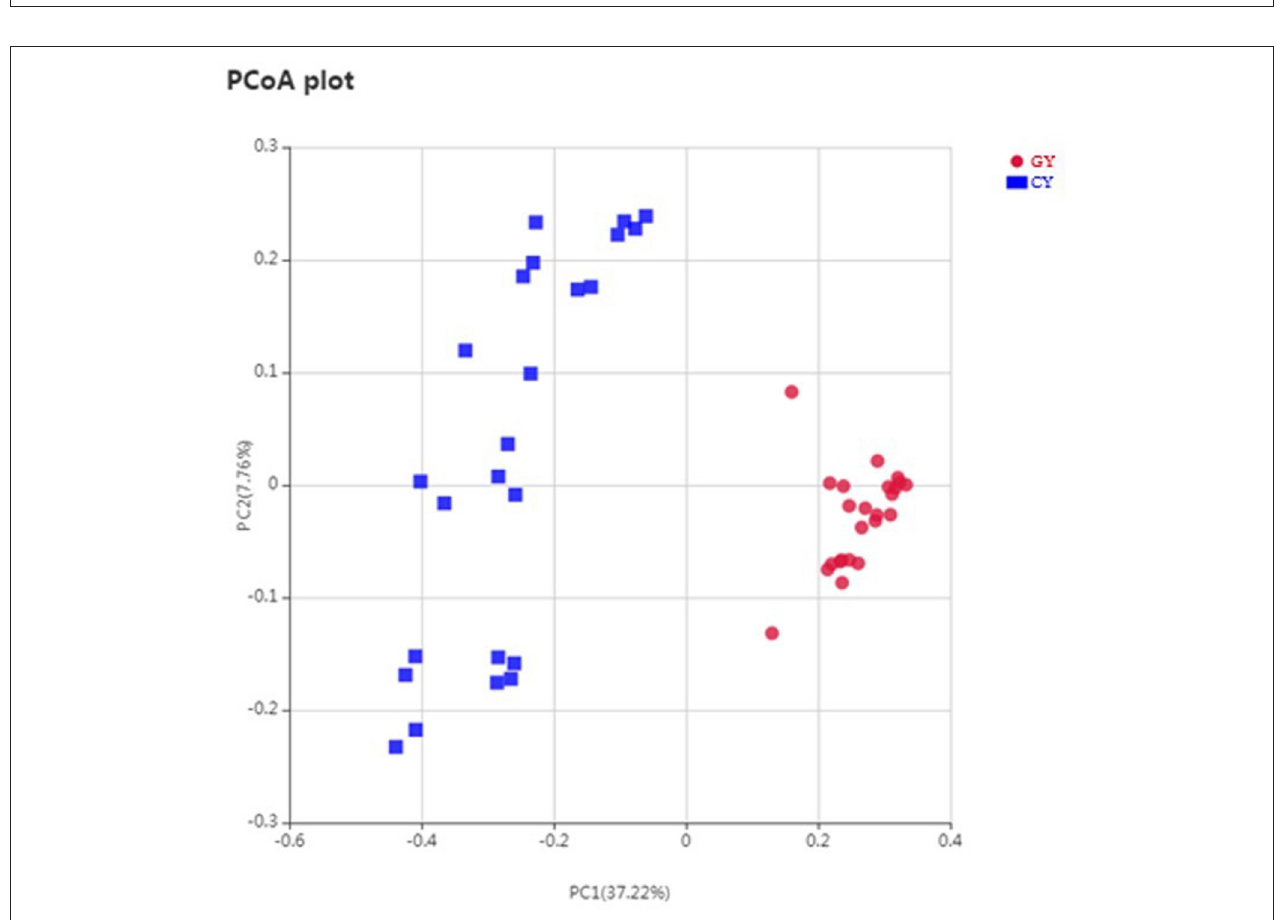
the dominant bacteria phyla including Firmicutes, Bacteroidetes, Proteobacteria, and Spirochaetes. The bacterial phyla, including Tenericutes, Melainabacteria, Verrucomicrobia, Fibrobacteres, Actinobacteria, unknown bacteria, and other phyla with lower count, showed no difference ( p > 0.05) in relative abundance between GY and